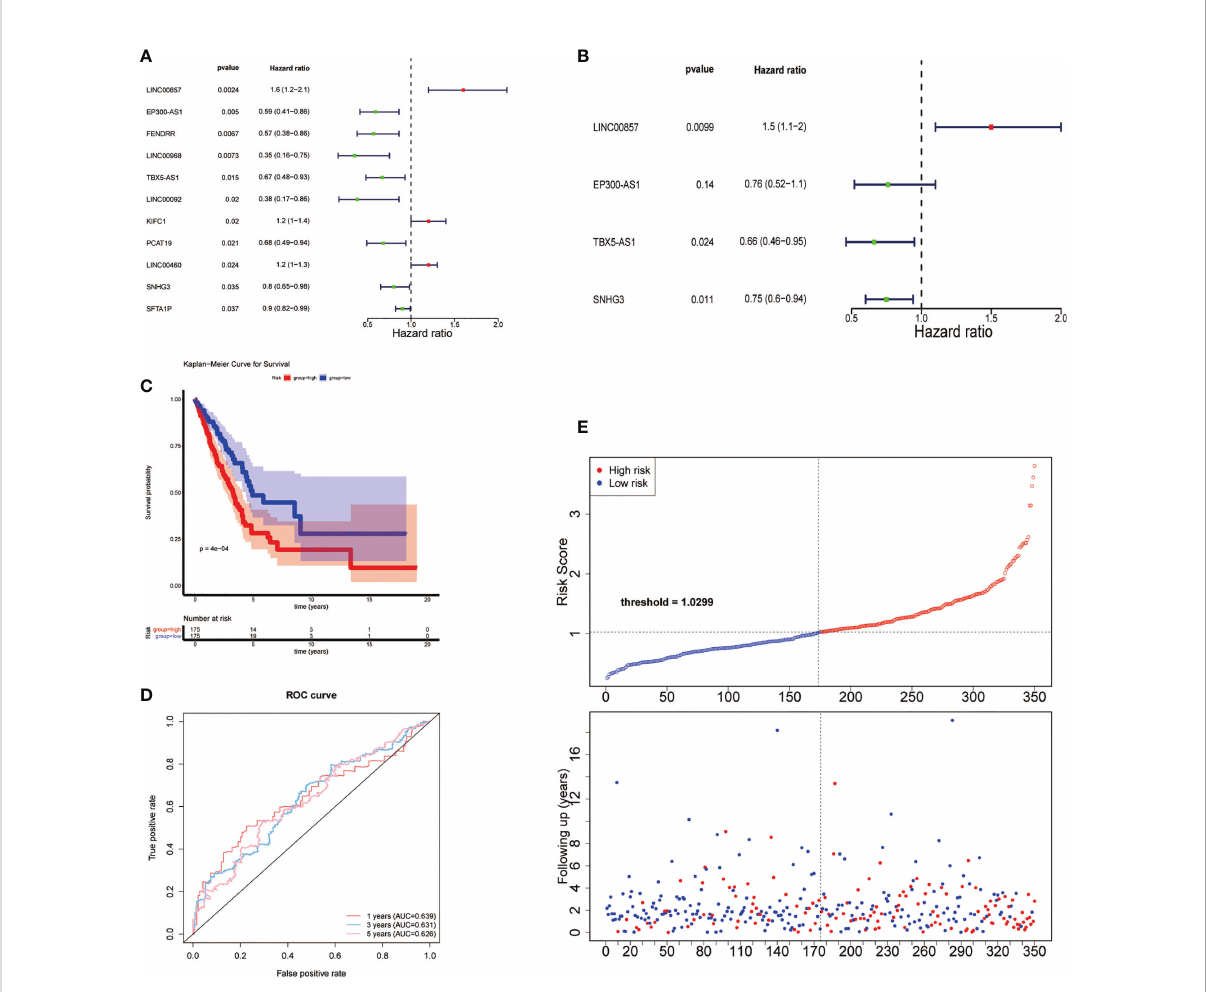
FIGURE 3 Construction of risk feature. (A) Forest plot of univariate Cox regression analysis results of lipid metabolism-related DE-lncRNAs. Red and green indicate risk and protective factors, respectively. (B) Forest plot of multivariate Cox regression analysis results of lipid metabolism-related DE- lncRNAs. (C) K – M survival curve of the risk score. (D) Time-ROC curve analysis of risk feature in 1, 3,5 years. (E) The distribution of risk scores, patient survival status, and survival time.